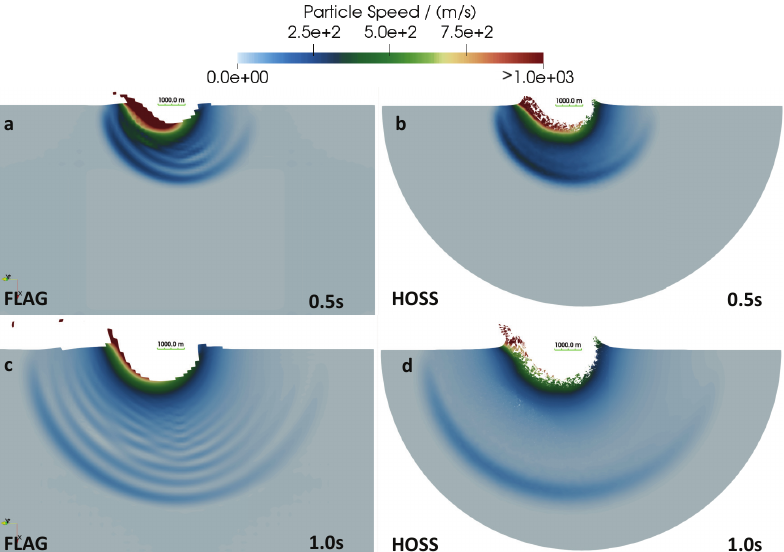
Figure 6. Particle velocity from a 5 × 10 3 m/s 45 ◦ oblique impact at 0.5 s ( a , b ) and 1.0 s ( c , d ) as calculated from 3D simulations from FLAG and HOSS. ( a , c ) show particle velocity for 3D FLAG simulations, and ( b , d ) show particle velocity for 3D Hoss simulations. The length of the horizontal green bar shown inside the crater represents a distance of 1000 m.